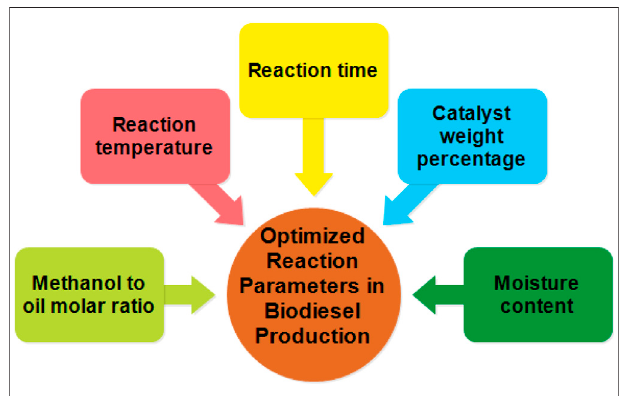
FIGURE 4 | Illustration of various optimization parameters in biodiesel